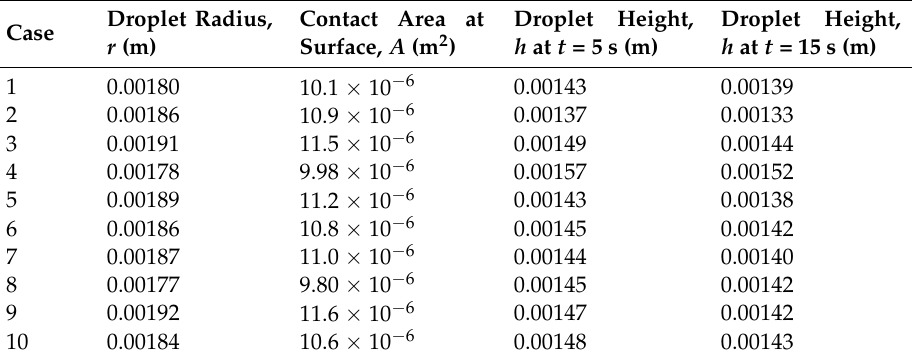
Table 4. Values of the droplets geometry in the repeatability study at t = 5 and 15 s when T plate = 333.15 K. Note that the radius of the droplets and contact areas at the heated surface are the same for both times.